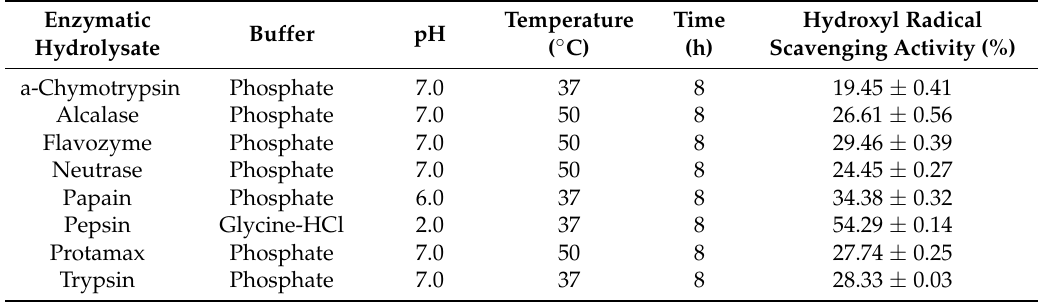
Table 2. Optimum conditions for the hydrolysis from duck processing by-product and hydroxyl radical scavenging activity of various enzymatic extracts (mg/mL).